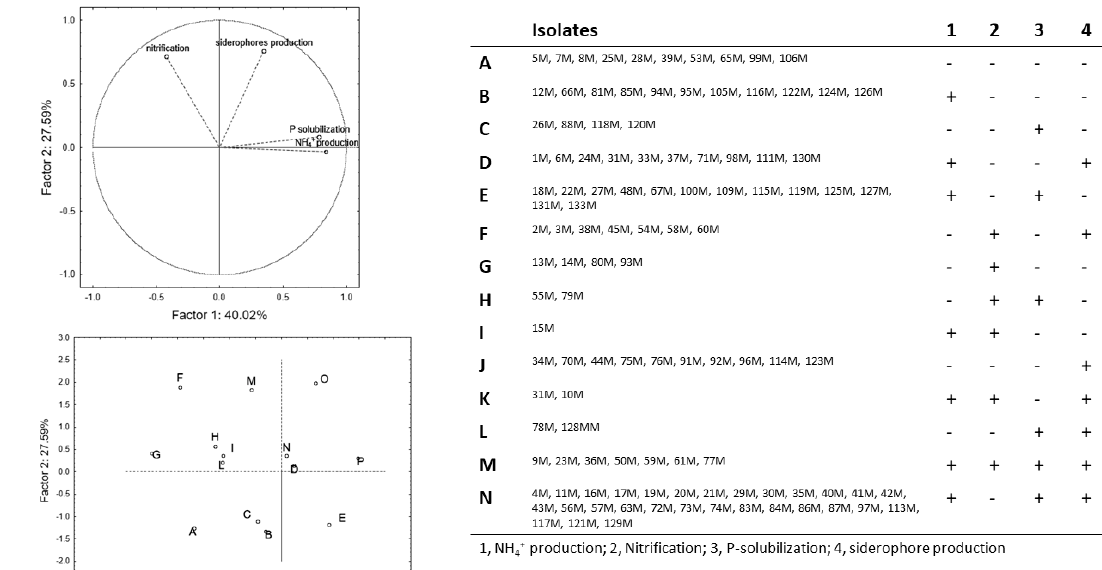
Figure 2. Principal component analysis run on the output to NH 4+ production, nitrification, P- solubilization, and siderophores production for the mesophilic bacteria.